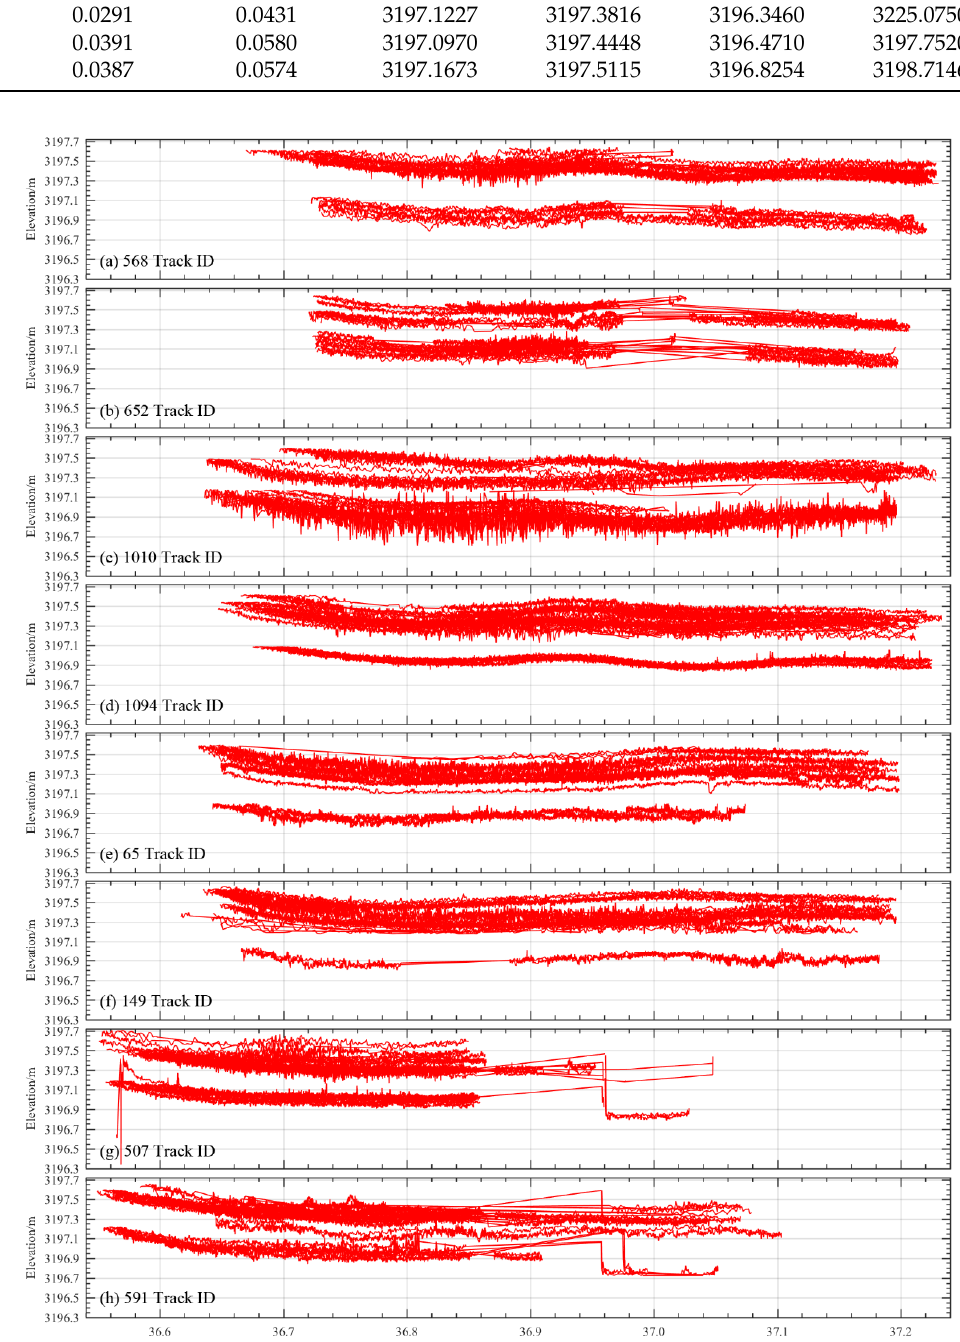
Figure 9. The elevation variation along the latitude in each track of ICESat-2, using the MAD outlier method.